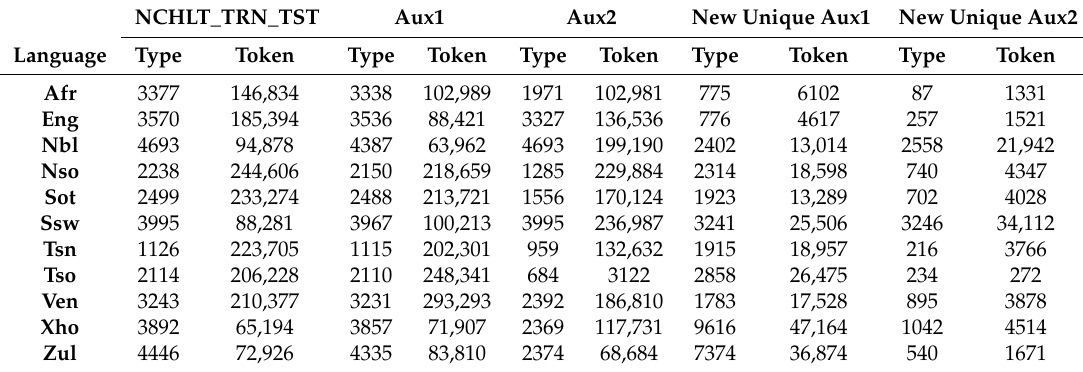
Table 5. Type and token counts for words in both NCHLT_TRN and NCHLT_TST. Aux1, Aux2: Type and token counts for words repeated in auxiliary data. New unique: Type and token counts for new words in auxiliary